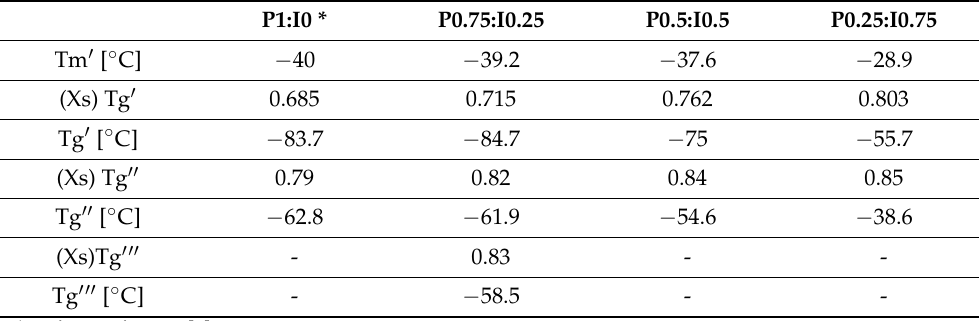
Table 4. Parameters estimated from the state diagrams of the pumpkin–inulin